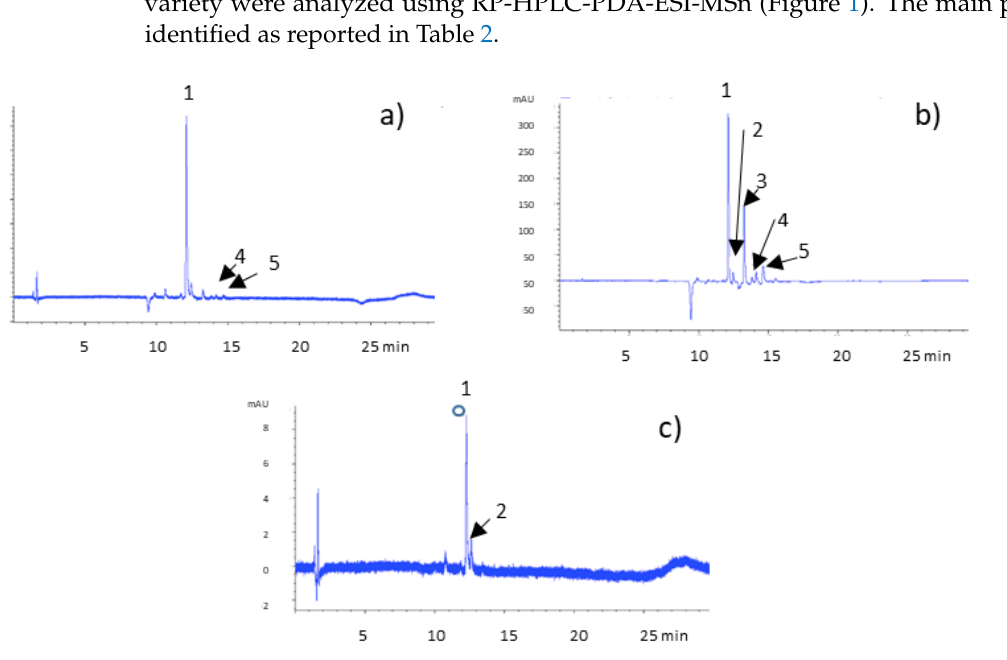
Table 1. Total polyphenol content (TPC) in four different A. cepa variety extracts.